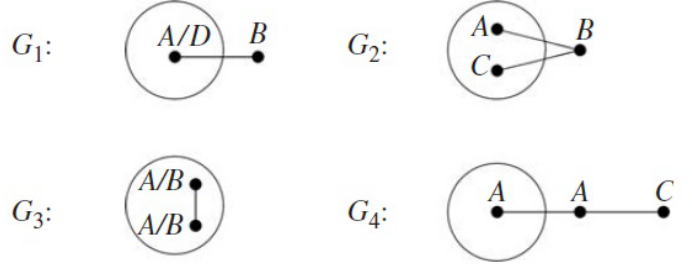
Figure 7. Vertex status of A, B, C and the four Operations